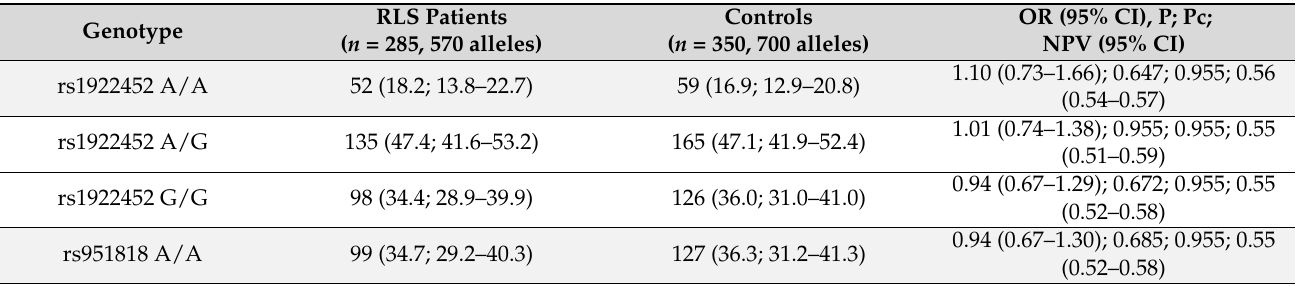
Table 1. Genotypes and allelic variants of patients with RLS and healthy volunteers. The values in each cell represent the number (percentage; 95% confidence intervals). P: crude probability; Pc: probability after multiple comparisons; NPV: negative predictive